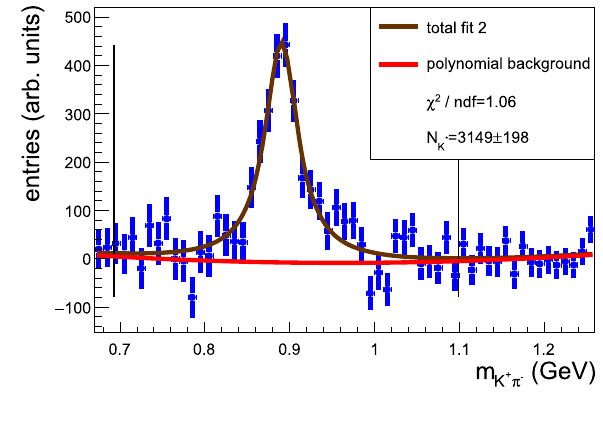
Fig. 4 Same as Fig. 3 but for p+p collisions at 80 GeV /